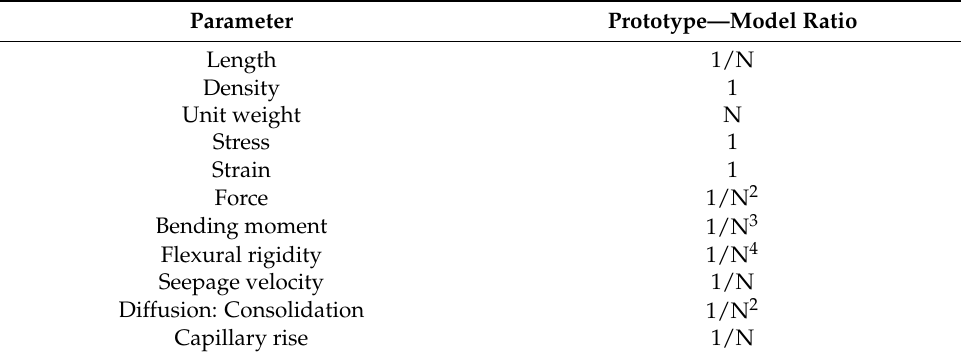
Table 4. Scaling laws for centrifuge modelling.